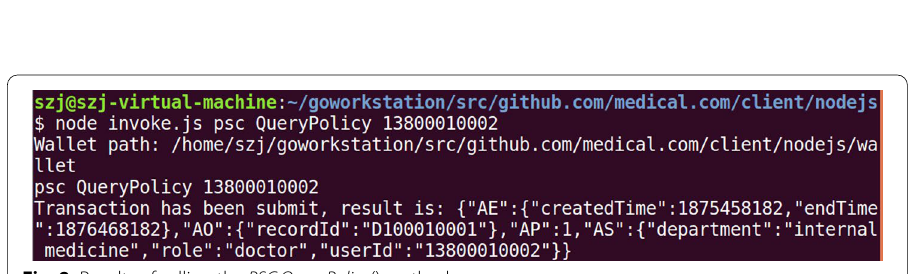
Fig. 8 Results of calling the PSC . QueryPolicy () method